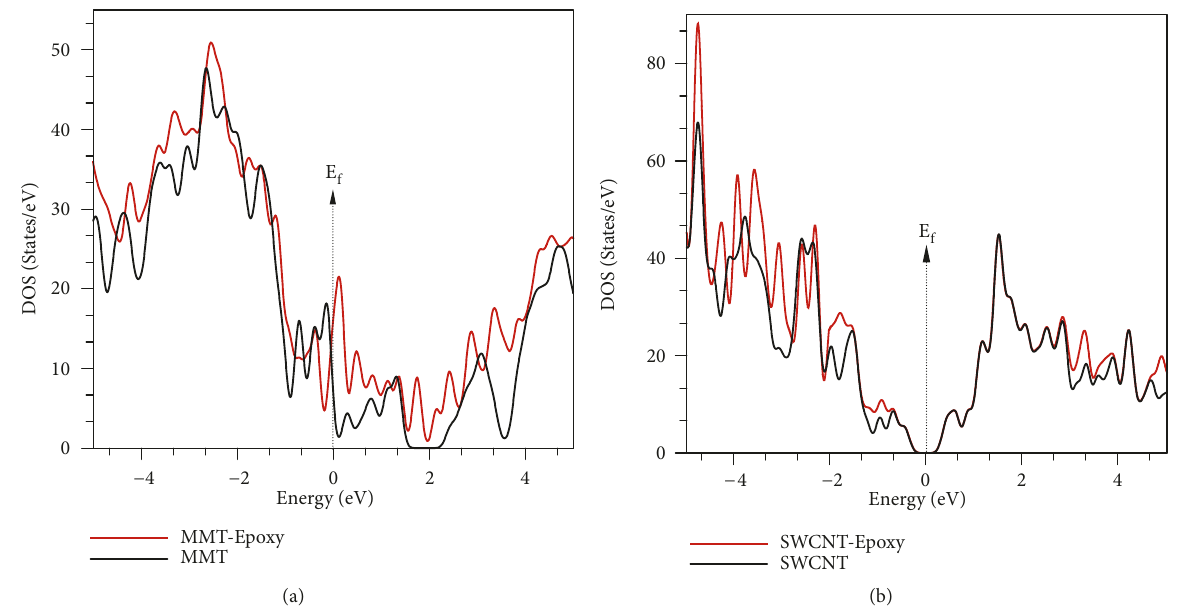
Figure 4: DOS diagrams of (a) montmorillonite nanoparticles and epoxy-montmorillonite nanocomposite and (b) SWCNT and Epoxy-